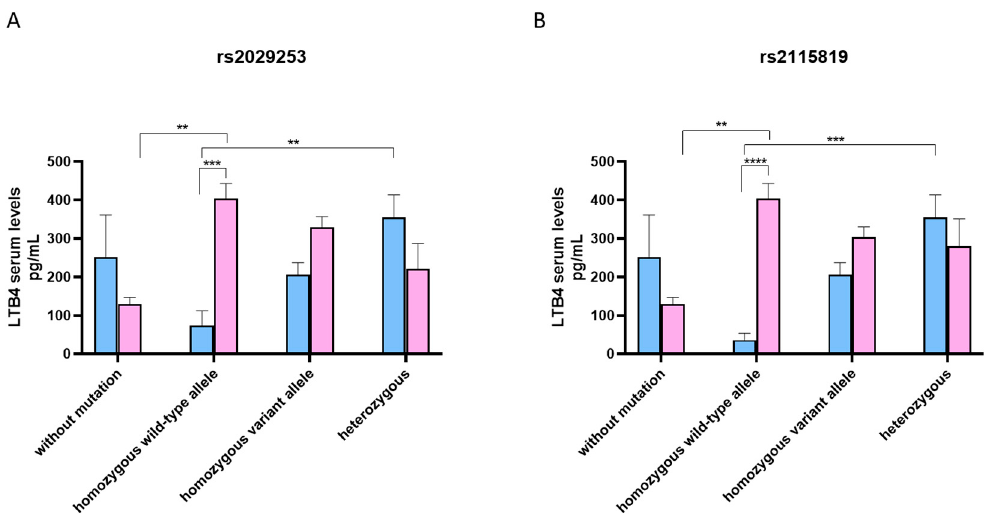
Figure 2. ( A ) Median LTB4 serum levels in M (blue) and W (pink) according to genotype ALOX5 rs2029253 polymorphism. Biological replicate: 4 M (2 healthy and 2 atopic) and 4 W (2 healthy and 2 atopic) without mutation; 4 M (all healthy) and 6 W (3 healthy and 3 atopic) carrying homozygous wild-type allele; 3 M (all healthy) and 4 W (3 healthy and 1 atopic) carrying homozygous variant allele; 6 M (3 healthy and 3 atopic) and 4 W (2 healthy and 2 atopic) carrying heterozygous alleles. ( B ) Median 5-LO serum levels in M (blue) and W (pink) according to genotype ALOX5 rs2115819 polymorphism. Biological replicate: 4 M (2 healthy and 2 atopic) and 4 W (2 healthy and 2 atopic) without mutation; 6 M (all healthy) and 8 W (4 healthy and 4 atopic) carrying homozygous wild-type allele; 6 M (all healthy) and 6 W (2 healthy and 4 atopic) carrying homozygous variant allele; 7 M (4 healthy and 3 atopic) 6 W (3 healthy and 3 atopic) carrying heterozygous alleles. All samples were run in duplicate and results were shown as means ± SEM. The statistical tests used in these analyses were the one-way analysis of variance followed by the Tukey Multiple Comparison Test. ** p < 0.01, *** p < 0.001, **** p < 0.0001.